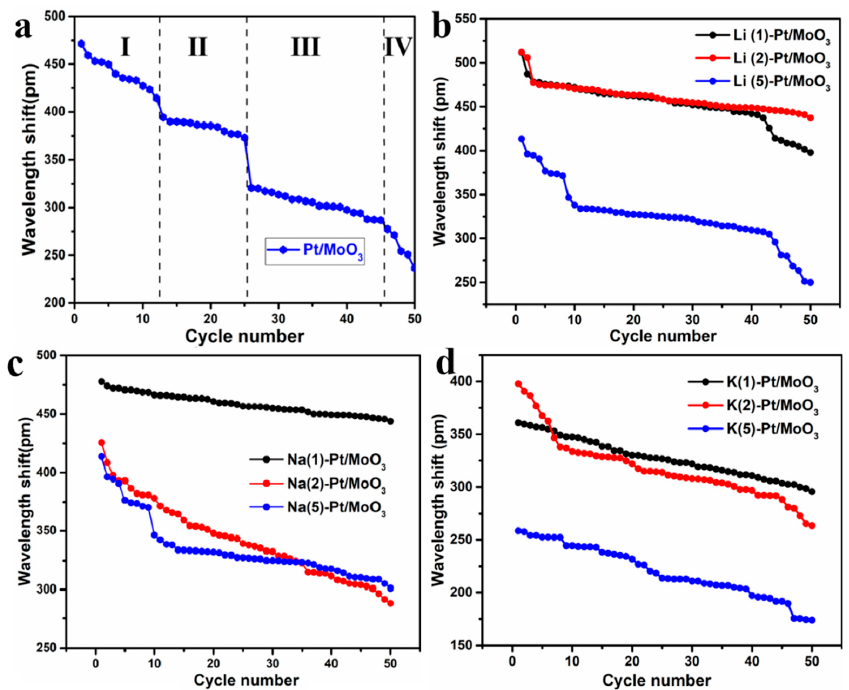
Figure 2. Repeatability of ( a ) Pt/MoO 3 , ( b ) Li + intercalated Pt/MoO 3 , ( c ) Na + intercalated Pt/MoO 3 and ( d ) K + intercalated Pt/MoO 3 .